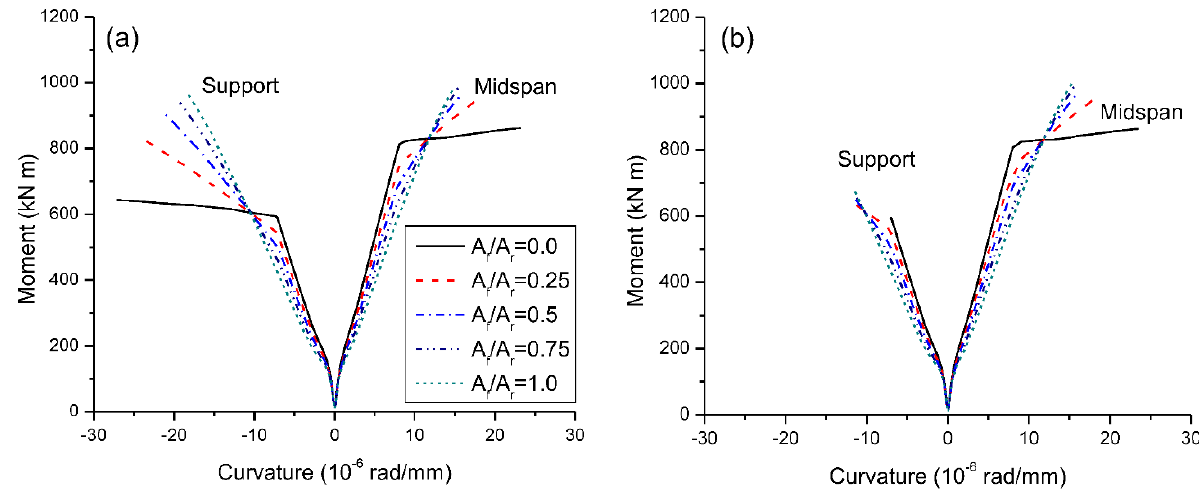
Figure 4. Moment-curvature behavior: ( a ) symmetrical loading; ( b ) unsymmetrical loading.